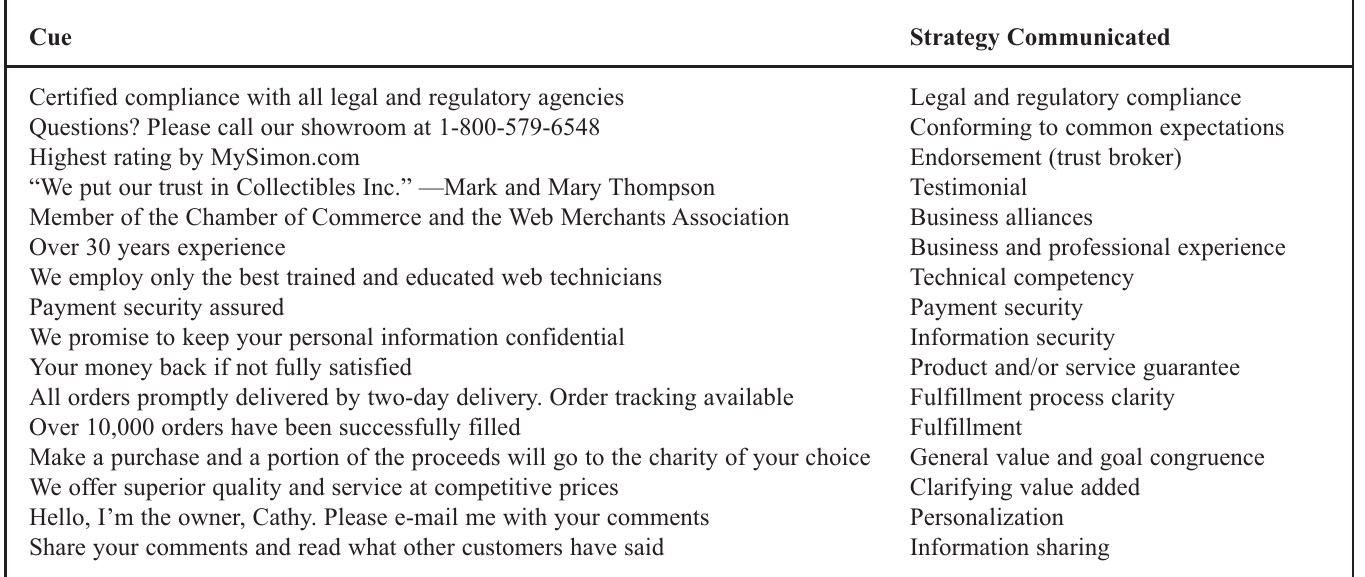
Communicated Cues and Their Respective